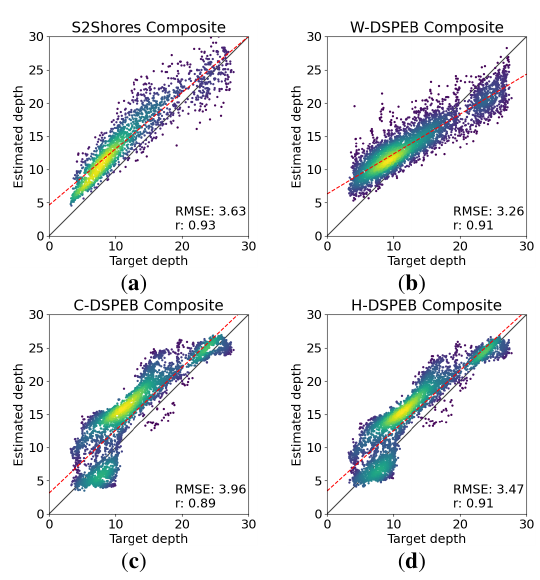
Figure 7. Pearson correlation score comparison of S2Shores ( a ),